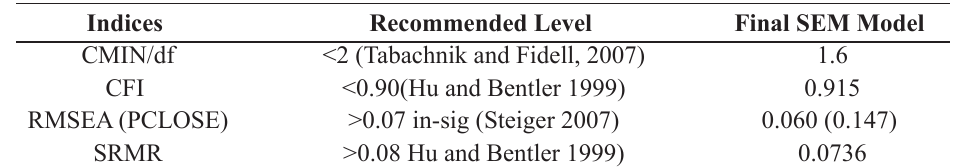
Table 4: SEM Model Fit Indices